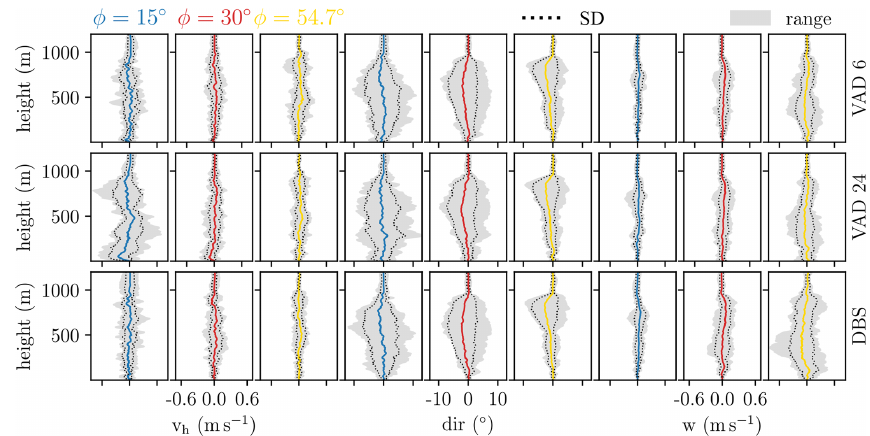
Figure A1. Ensemble case 1: vertical profiles of ensemble mean deviations from the respective reference profiles for different zenith angles and scan configurations (VAD 24, VAD 6 and DBS) for an averaging interval of 60min. Blue lines refer to a zenith angle configuration of 15 ◦ , red lines refer to a zenith angle configuration of 30 ◦ , and yellow lines refer to a zenith angle configuration of 54.7 ◦ . The three leftmost panels display wind speed, the three center panels display wind direction, and the three rightmost panels display vertical wind speed. The x -axis scaling also applies to the respective adjacent panels. Also shown is the range over all ensemble members (gray areas) as well as standard deviation from the mean (dotted lines). Reference profiles of horizontal wind speed, wind direction and vertical wind speed were taken along the vertical column directly above the lidar location for each